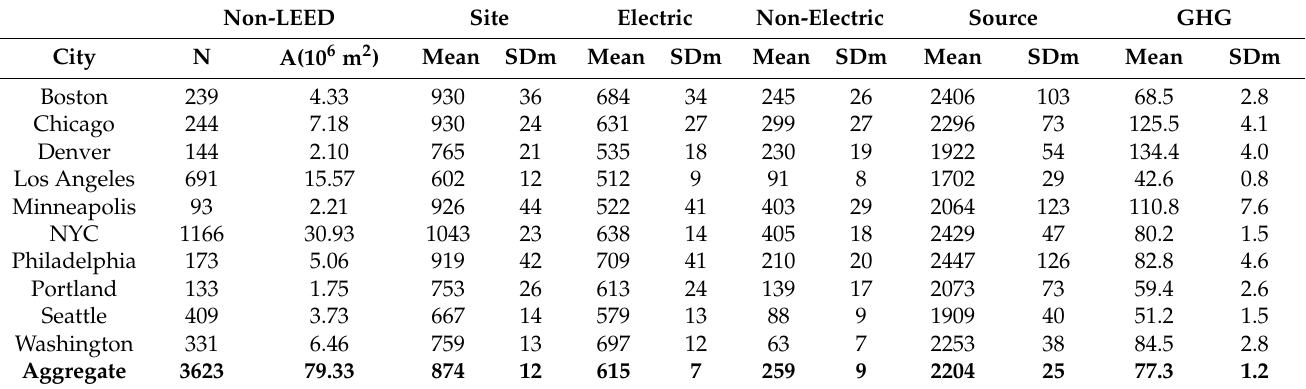
Table 1. Area-weighted mean intensity metrics for non-LEED offices. SDm is the standard deviation of the weighted mean calculated using the bootstrap method with 10,000 replicates. Four energy intensities are in MJ/m 2 and GHG intensity in kg/m 2